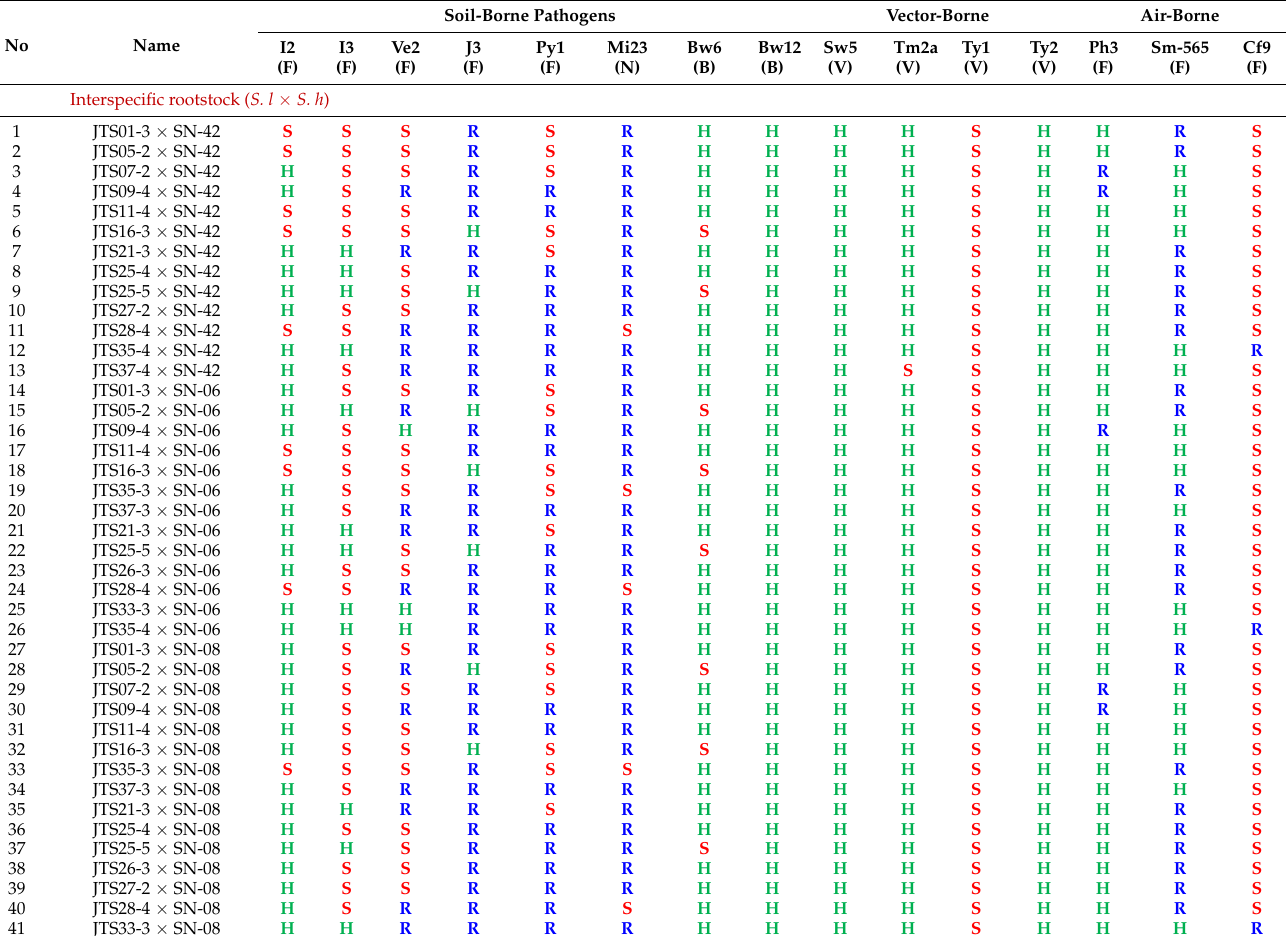
Table 3. List of gene/loci of hybrid new combination; interspecific ( S. l × S. h ), intraspecific ( S. l × S. l ), and commercial rootstock